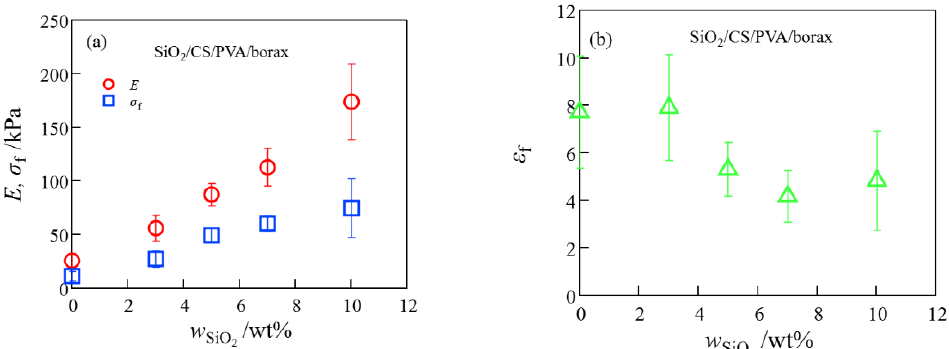
Figure 2. The Young’s modulus and the fracture stress ( a ) and the fracture strain ( b ) of SiO 2 /CS/PVA hydrogels at different SiO 2 concentrations.